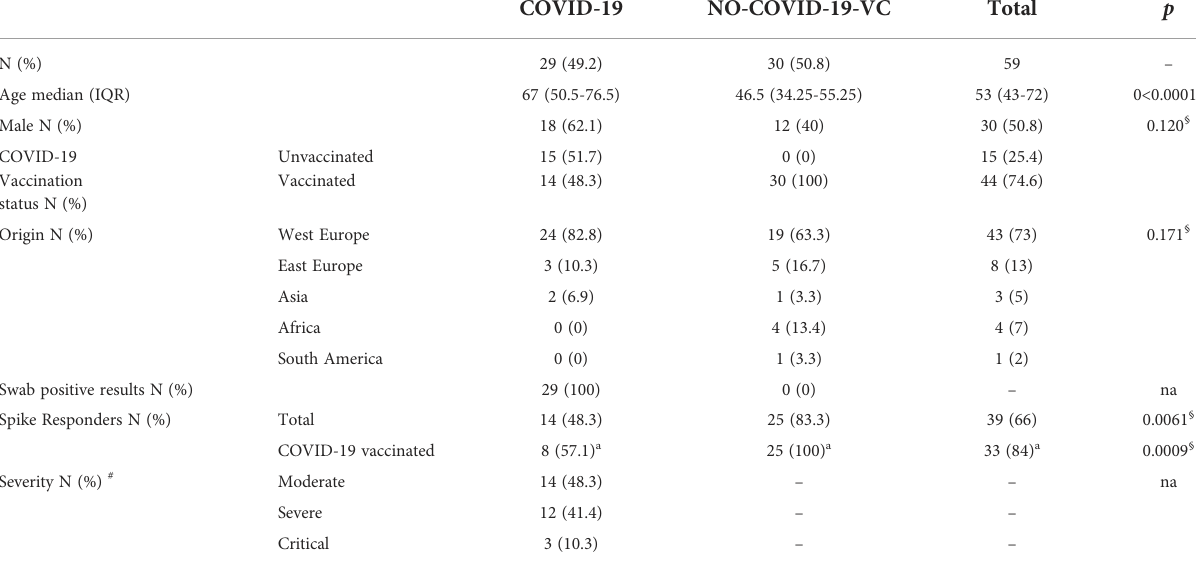
TABLE 2 Demographical and clinical characteristics of the study population “ B ” for evaluating the effect of IL-10 on the SARS-CoV-2 speci fi c immune